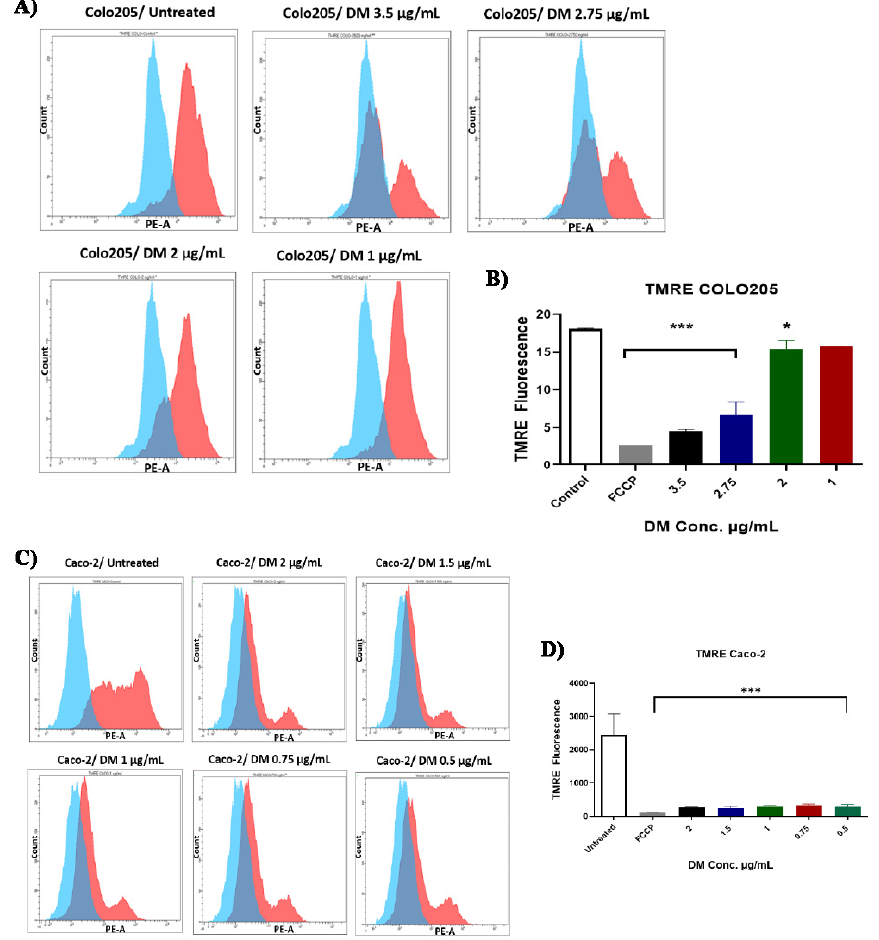
Figure 5. Assessment of the mitochondrial membrane potential ( ∆Ψ m) in COLO-205 and Caco-2 cells after treatment with D. maritima (DM) bulb extract for 48 h: ( A , B ) Histograms and bar graphs show changes in COLO-205 cells ∆Ψ m response to various concentrations of DM extract (3.5 µ g/mL, 2.75 µ g/mL, 2 µ g/mL, 1 µ g/mL, and 0.5 µ g/mL) in comparison to untreated cells. ( C , D ) Histogram (2 µ g/mL, 1.5 µ g/mL, 1 µ g/mL, 0.75 µ g/mL, and 0.5 µ g/mL) compared to control (untreated